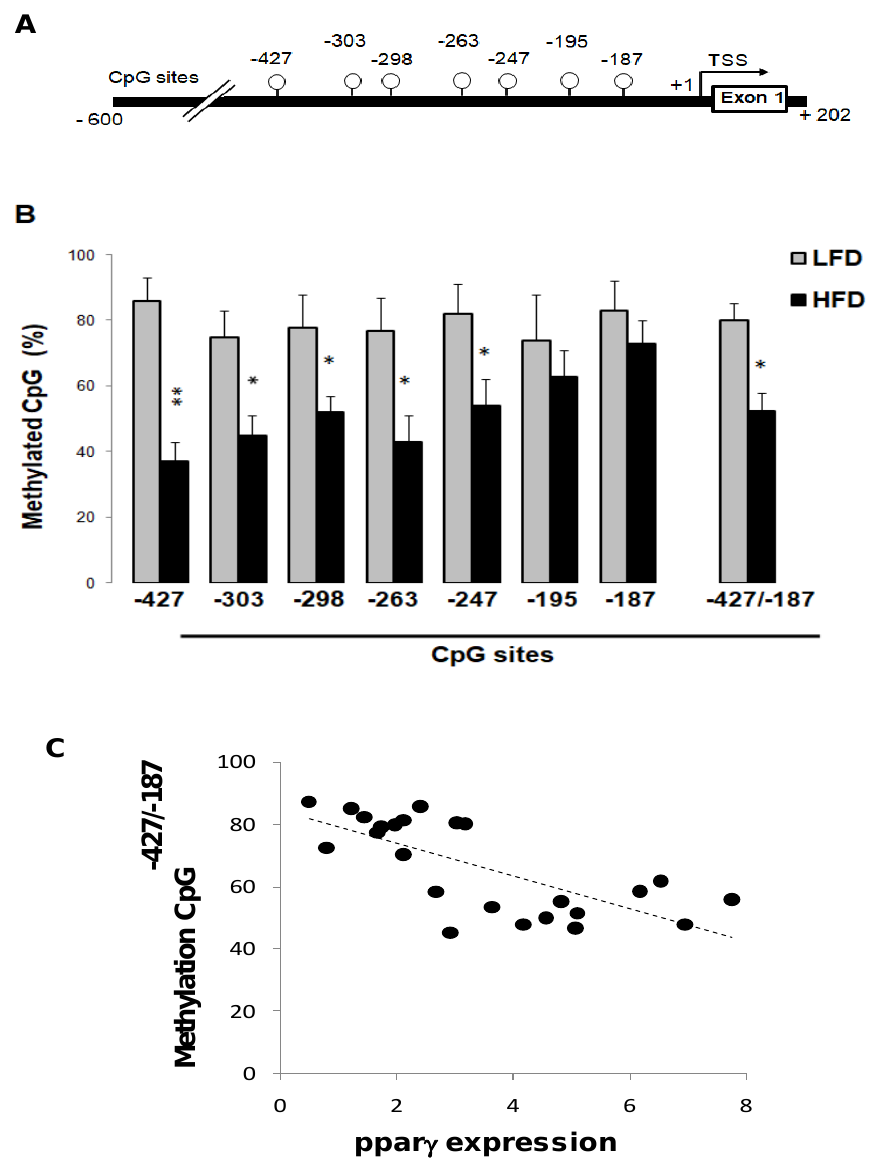
Figure 4. High-fat diet reduced ppar γ DNA promoter methylation. Representative map of CpG sites in ppar γ DNA promoter ( A ), methylation level of CpG sites in ppar γ promoter ( B ),and correlation of ppar γ mRNA and ppar γ promoter methylation level ( C ). Hepatic DNA was isolated from mice fed LFD and HFD, and the DNA methylation profile of individual CpG sites in the ppar γ promoter was assessed with bisulfate pyrosequencing analysis ( n = 8), as described in Methods. Different from LFD, * * p < 0.01 and * p < 0.05.